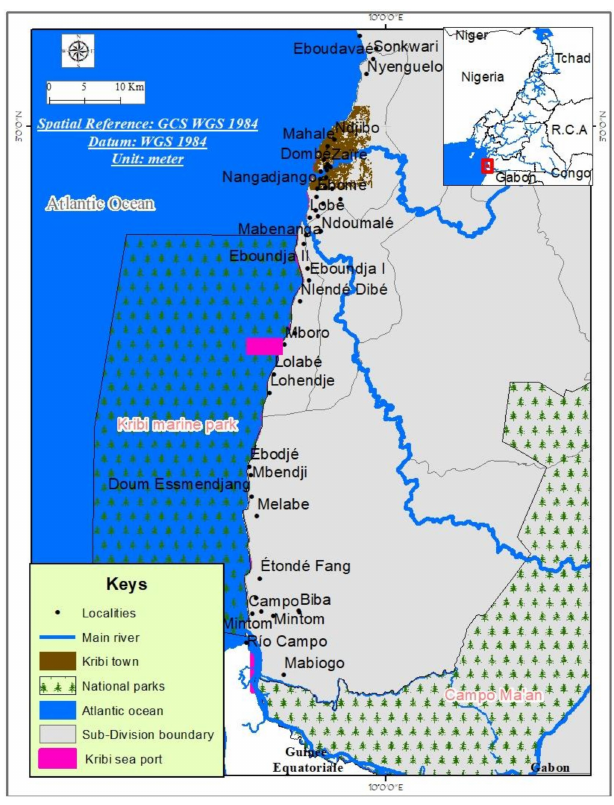
Figure 1. Location map of the study